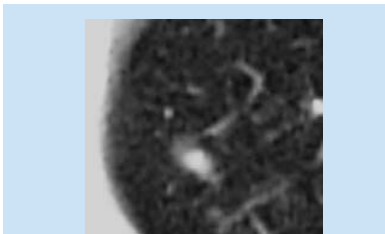
Fig. 4a. Halo sign.